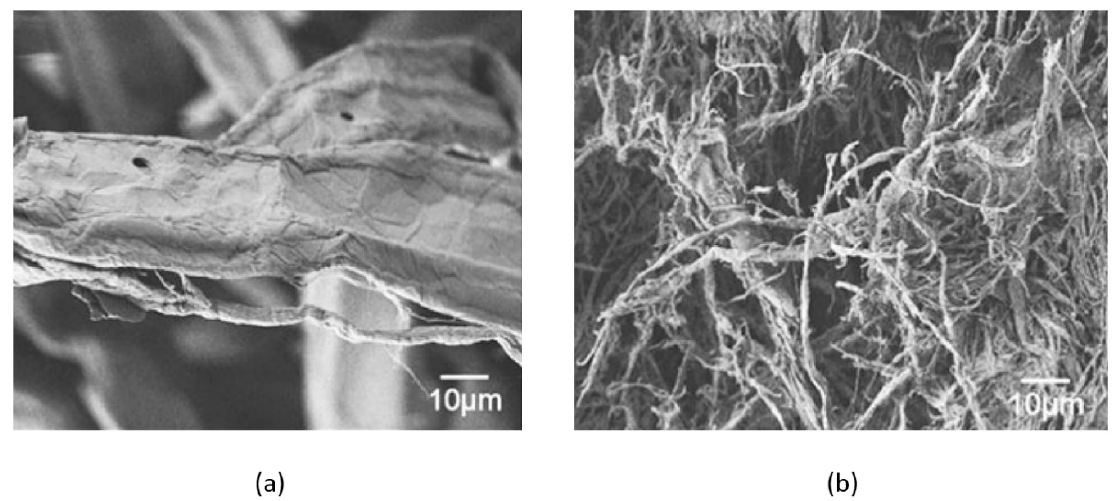
Figure 5. Starting pulp ( a ) and fibrillated cellulose from final composite after extraction of the polymer matrix ( b ). Reproduced with permission from Suzuki, et al. [38], Cellulose, Springer Nature B.V., 2013.